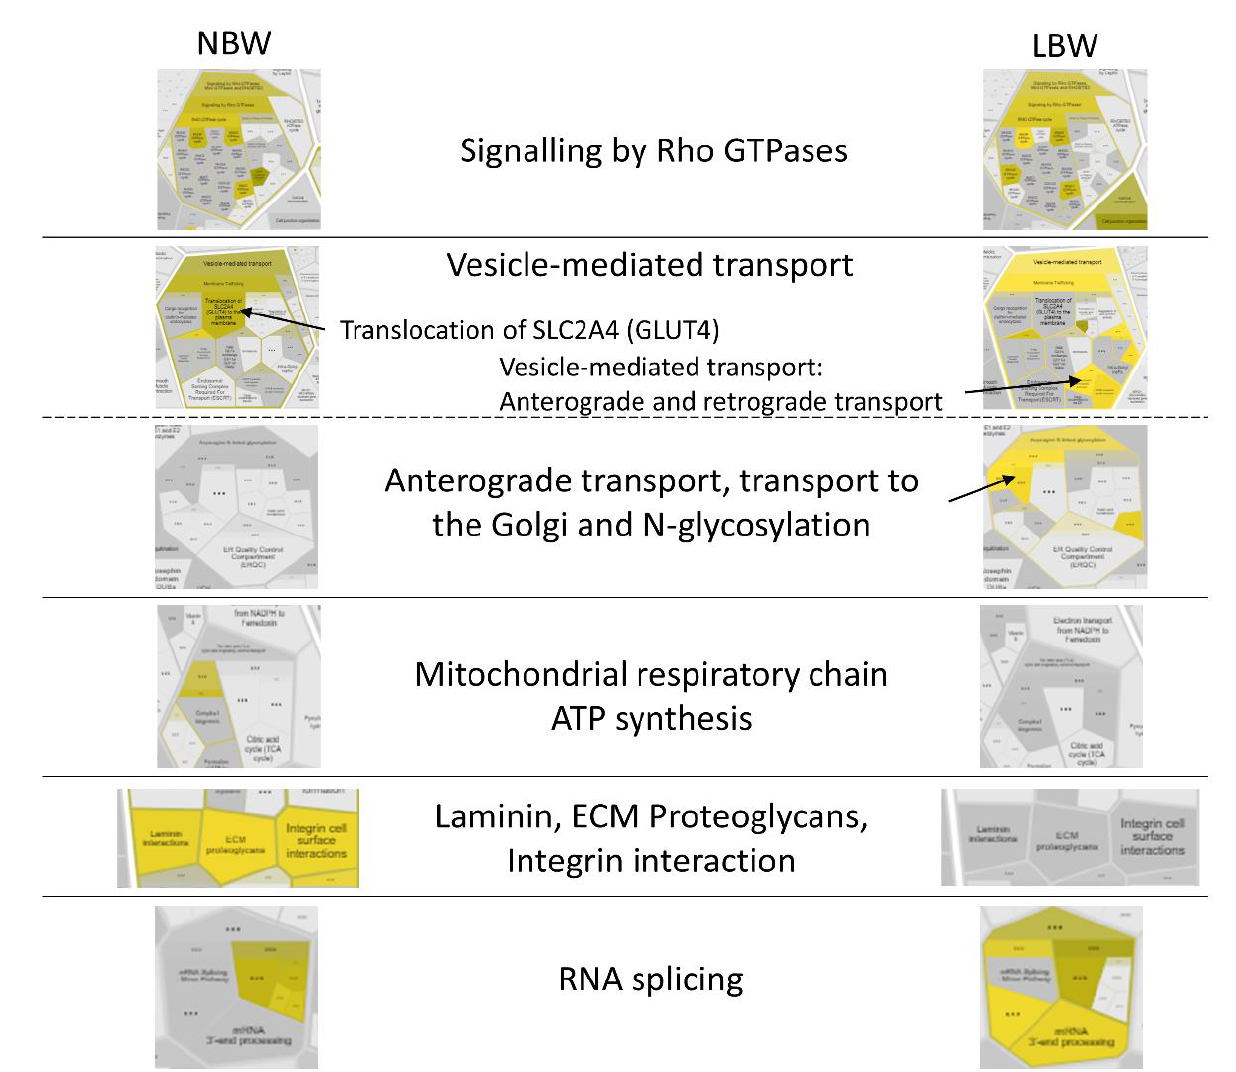
Figure 6. Voronoi diagram sections obtained with Reactome showing the main pathways regulated by an HFD in NBW and LBW groups. Intensity of yellow color indicates abundance of DAPs in a specific pathway. The complete Voronoi picture and images with enlarged letter size is shown in Supplementary Figure S1.